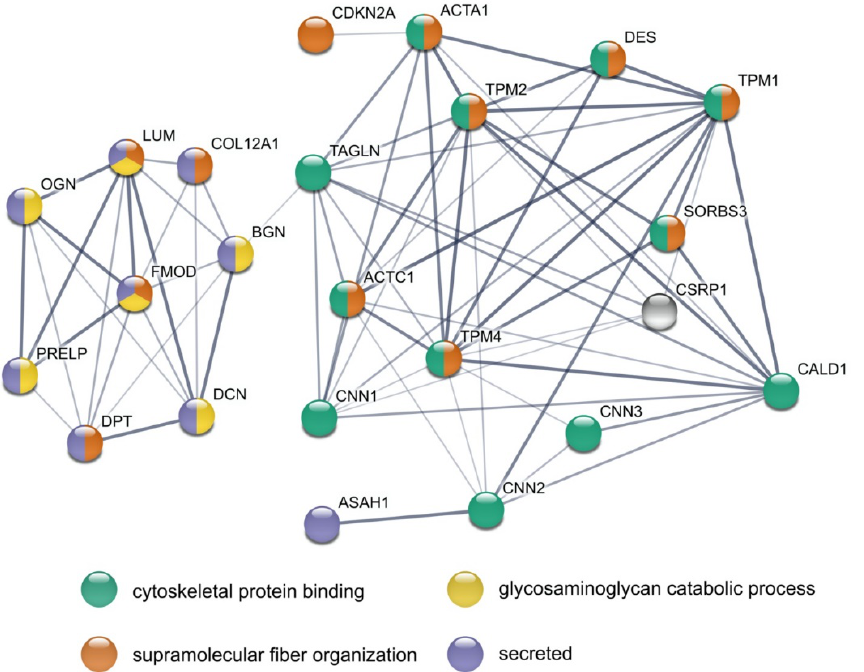
Figure 5. STRING analysis of all differentially abundant proteins in the testis of old vs. young donors. Nodes represent individual proteins and are colored based on the four annotations indicated at the bottom of the figure. Line strength indicates confidence level from low (0.150) to highest (0.900).